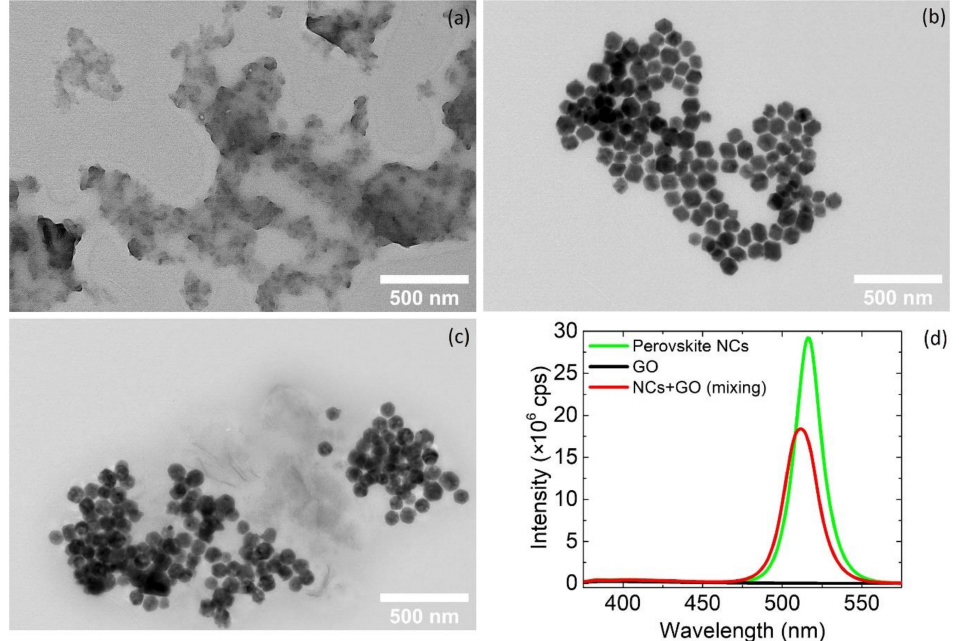
Figure 3. ( a – c ) TEM images of the exfoliated graphene oxide (GO) in 1,2–dichlorobenzene (DCB), of the metal halide nanocrystals in the same solvent and the mixture of the two before the laser irradiation; ( d ) Photoluminescence spectra of the same